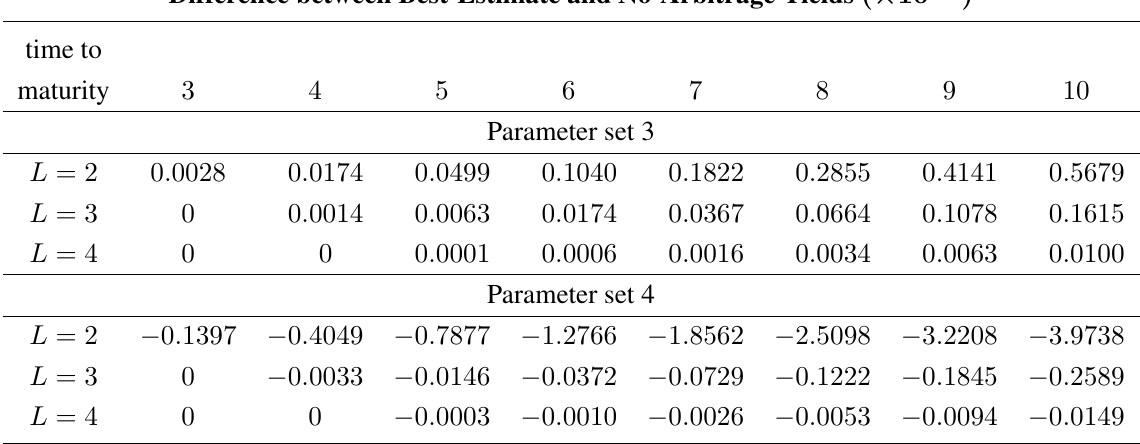
Table 4. Differences between the best-estimate and the no-arbitrage yields for different numbers L of traded bonds, for Parameter sets 3 and